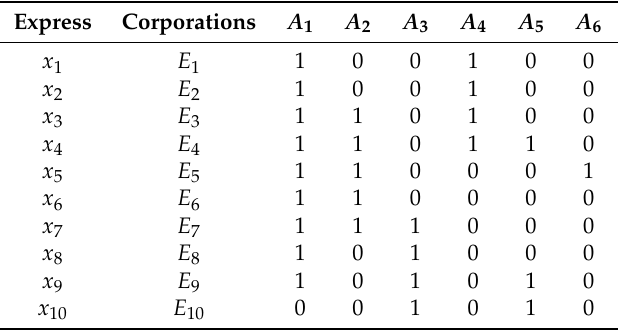
Table 4. Corporations having